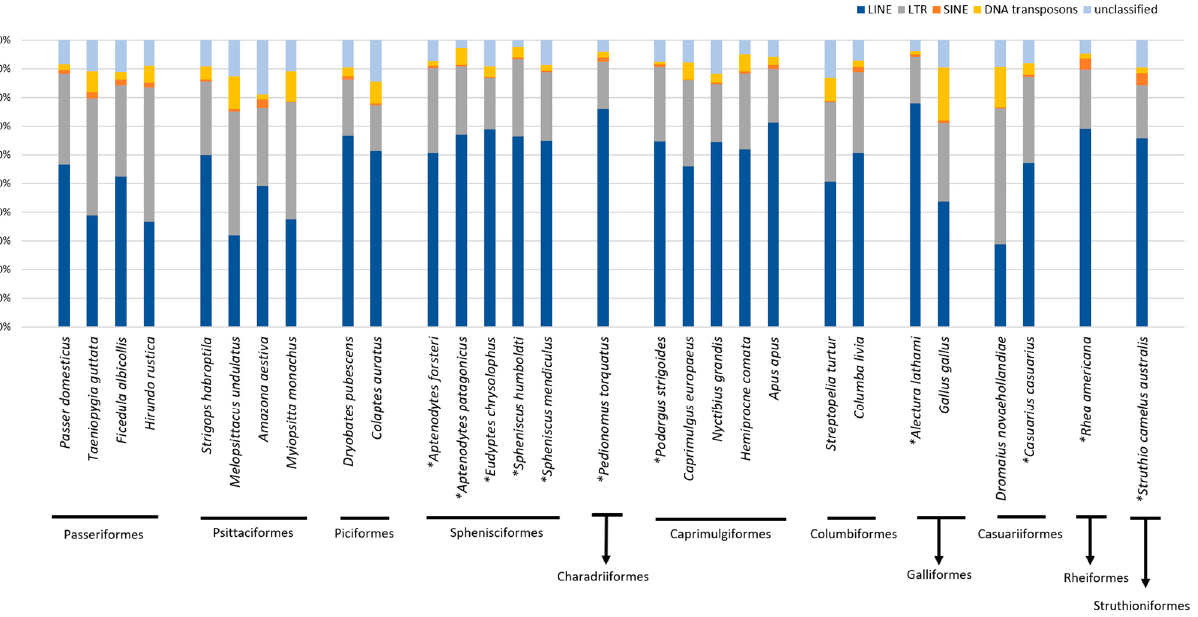
Figure 4. Venn diagrams obtained by the variation partitioning analysis (VPA) using redundancy analysis (RDA). The partition of the variation of a response variable (X) between two sets of explan- atory variables (X1 and X2) is shown. Each circle represents the portion of variation accounting for each explanatory variable or a combination of the explanatory matrices. The intersection between the two circles represents the amount of variation explained by both variables X1 and X2. The re- sponse variable (X) is the difference between the LTR retroelements relative abundances; the ex- planatory variable X1 represents species that have an ancestor that probably experienced an LTR expansion as consequence of climate changes that occurred in Australia and Antarctica during the Eocene-Oligocene transition; the explanatory variable X2 indicates the sequence divergence ob- tained by p-distance matrix using 16S rDNA sequences. Genomic TE sequence divergence was analyzed using Kimura distance method (Sup- plementary Figure S2). In Figure 5, Kimura landscapes were reported for Passeriformes (passerines), Psittaciformes (parrots), and Palaeognathae (ratites and tinamous), taxa that have species with an abundance of LTR retroelements.